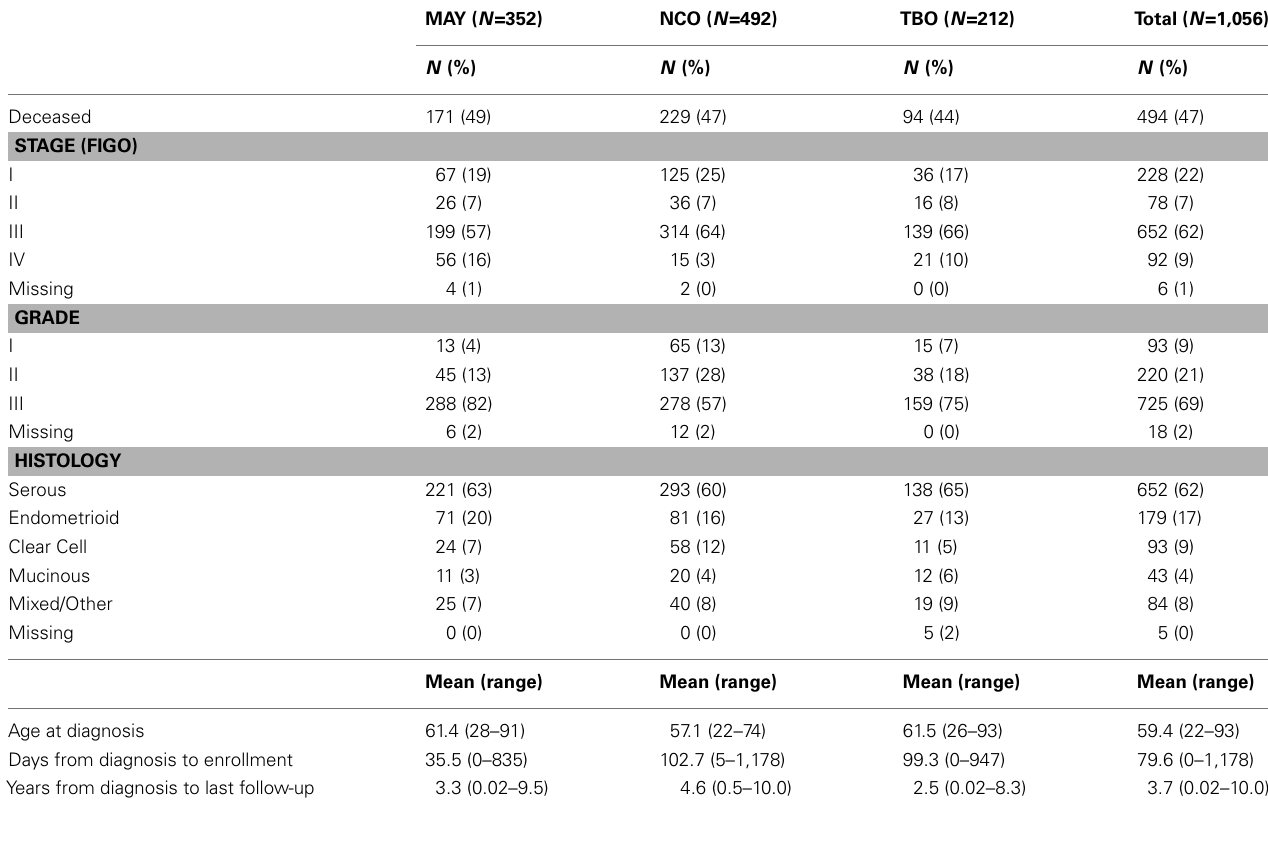
Table 1 | Clinical characteristics of invasive epithelial ovarian cancer